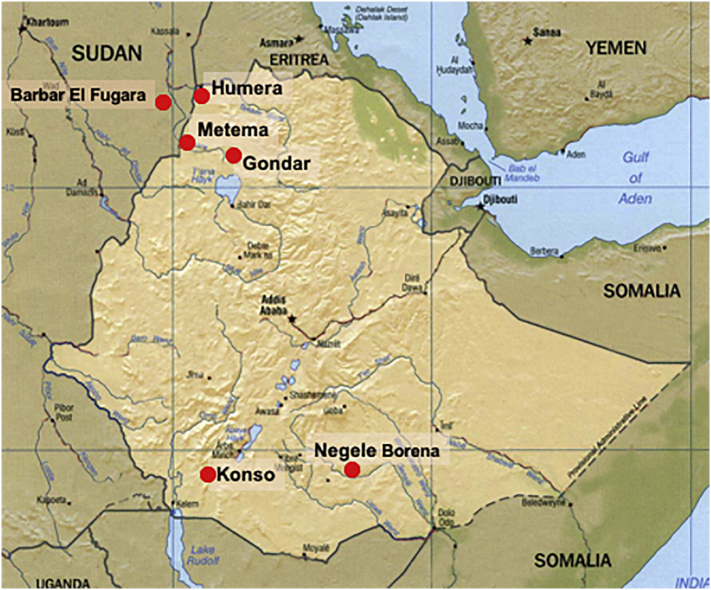
Map indicating the sites where the Leishmania donovani strains examined in this study were isolated in Sudan and Ethiopia. This figure was adapted from Gelanew et al., 2010b.